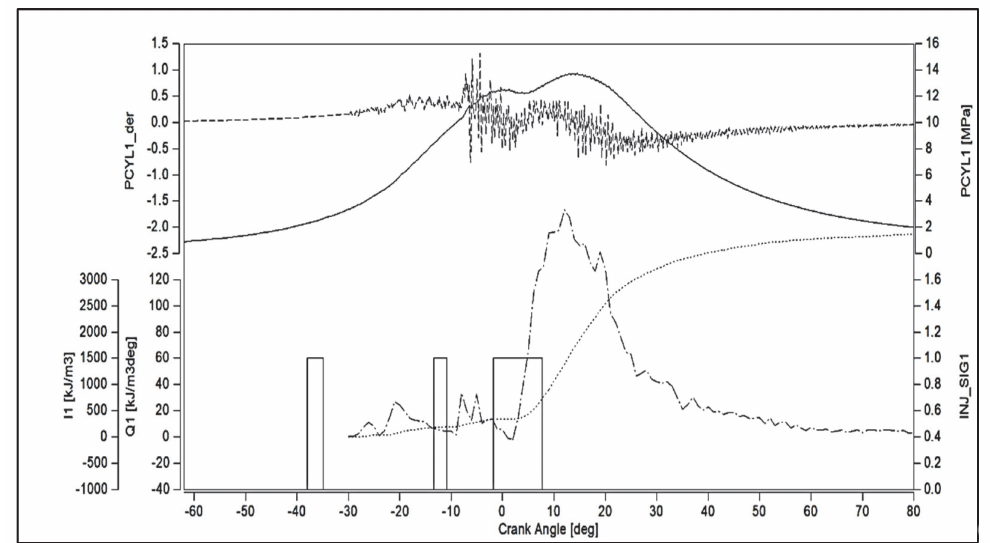
Figure 9. The waveform of the main injection and combustion parameters (MOD1), i.e., the rate of heat of combustion (Q1), the amount of heat of combustion (L1), the combustion pressure (PCYL1), the rate of combustion pressure build ‐ up (PCYL1_der) and the injector control signal (INJ_SIG1) — under the established engine operating conditions, engine speed 2000 [rpm] and load 130 [Nm].